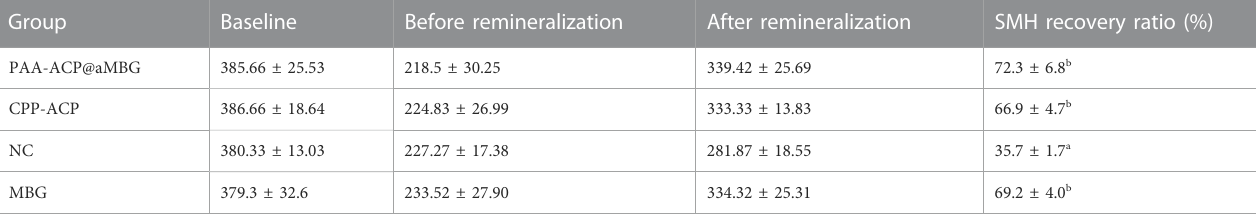
TABLE 2 SMH values (mean ± SD, VHN) and SMH recovery rates (mean ± SD, %) of the four groups at different time points ( n = 10). Group